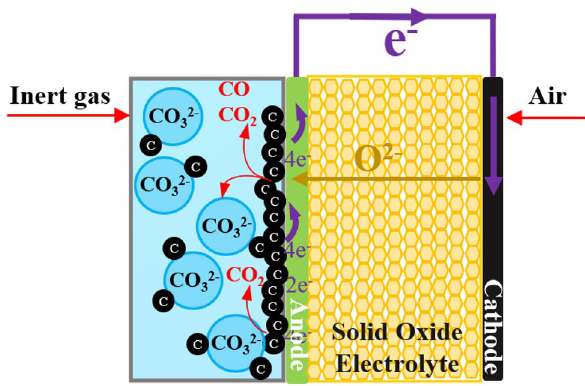
Fig. 5 Schematic diagram of the SOFC + MCFC system: O electrons and then produces O 2− at the cathode; O 2− then passes through a solid oxide electrolyte and arrives at the electrolyte/anode interface, where it reacts with carbon to produce CO, CO 2 and elec-